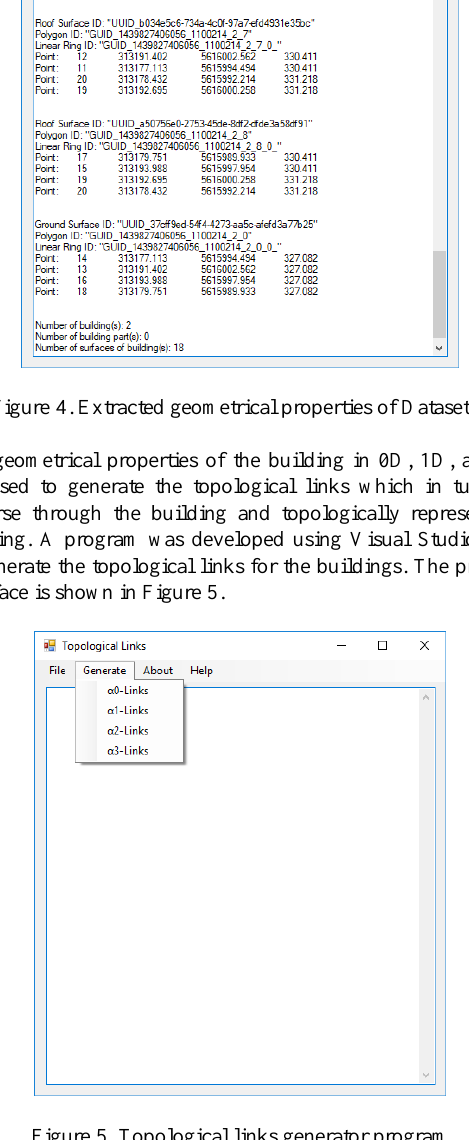
Figure 5. Topological links generator